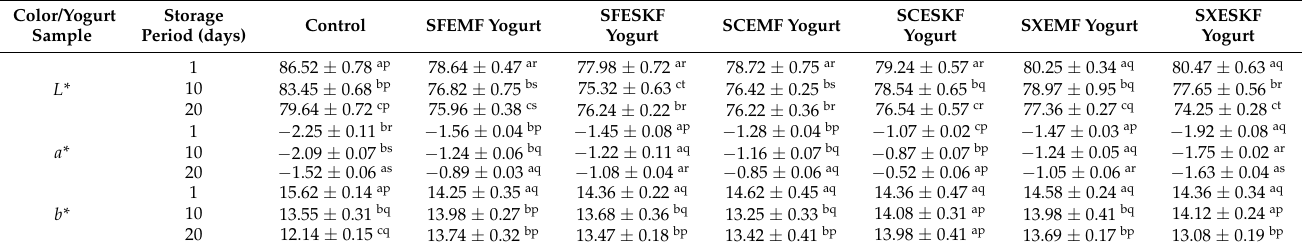
Table 3. Color attributes of functional liquid yogurt containing extracts from Majdool (MF) and Sukari (SKF) obtained using supercritical fluid (SFE), subcritical CO 2 (SCE) and Soxhlet (SXE) extraction techniques during storage at 4 ◦ C for 20